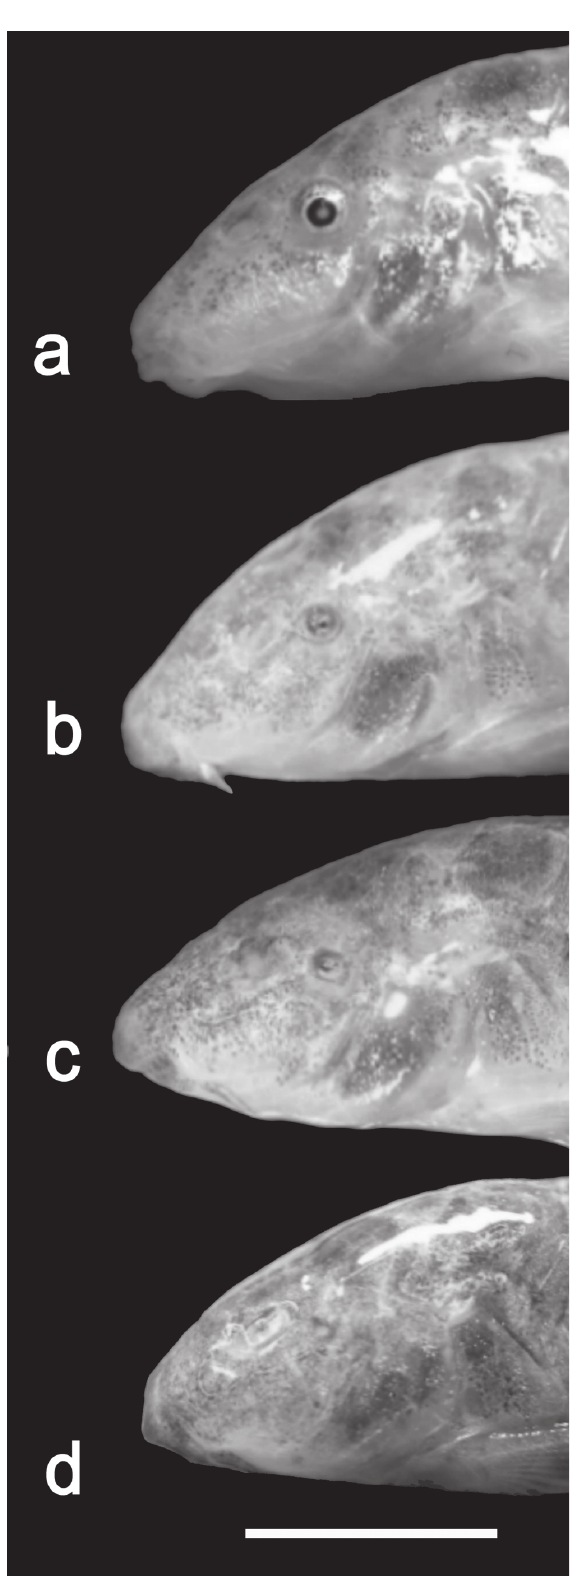
Fig. 5 . Eye variation in 15 months old juveniles of cave Aspidoras albater born in laboratory. a ) eye apparently functional; b ) and c ) eye severely reduced and possibly non functional; and d ) eye covered and non functional. Scale bar = 5